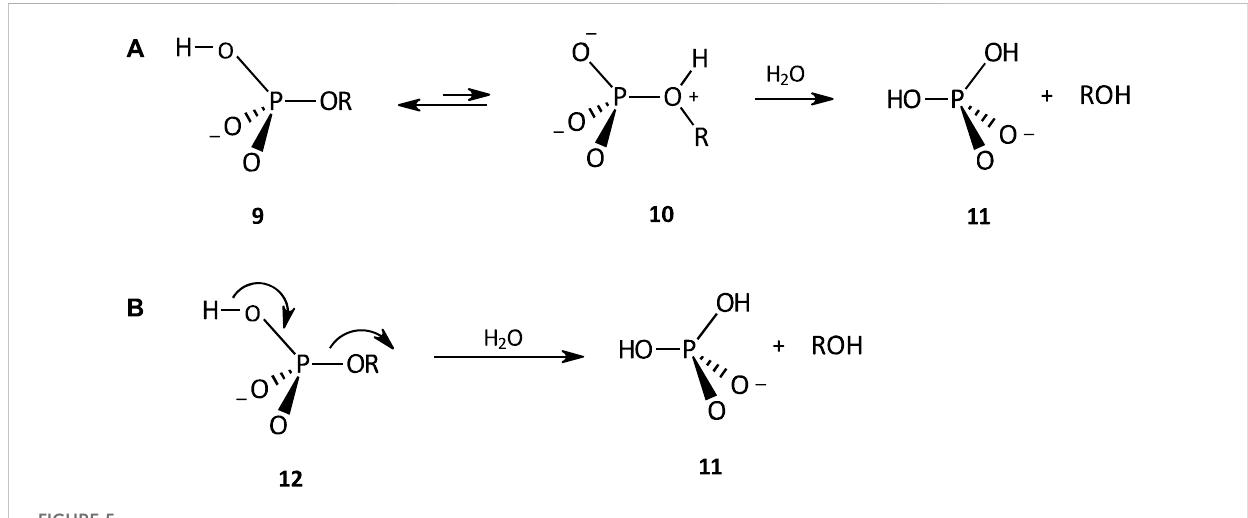
FIGURE 5 The hydrolysis of a phosphate monoester monoanion involving (A) an internal proton transfer pre-equilibrium to generate the dipolar species 10 , from which ROH, a powerful leaving group, is expelled, and (B) simultaneous proton transfer and leaving group departure, to yield 11